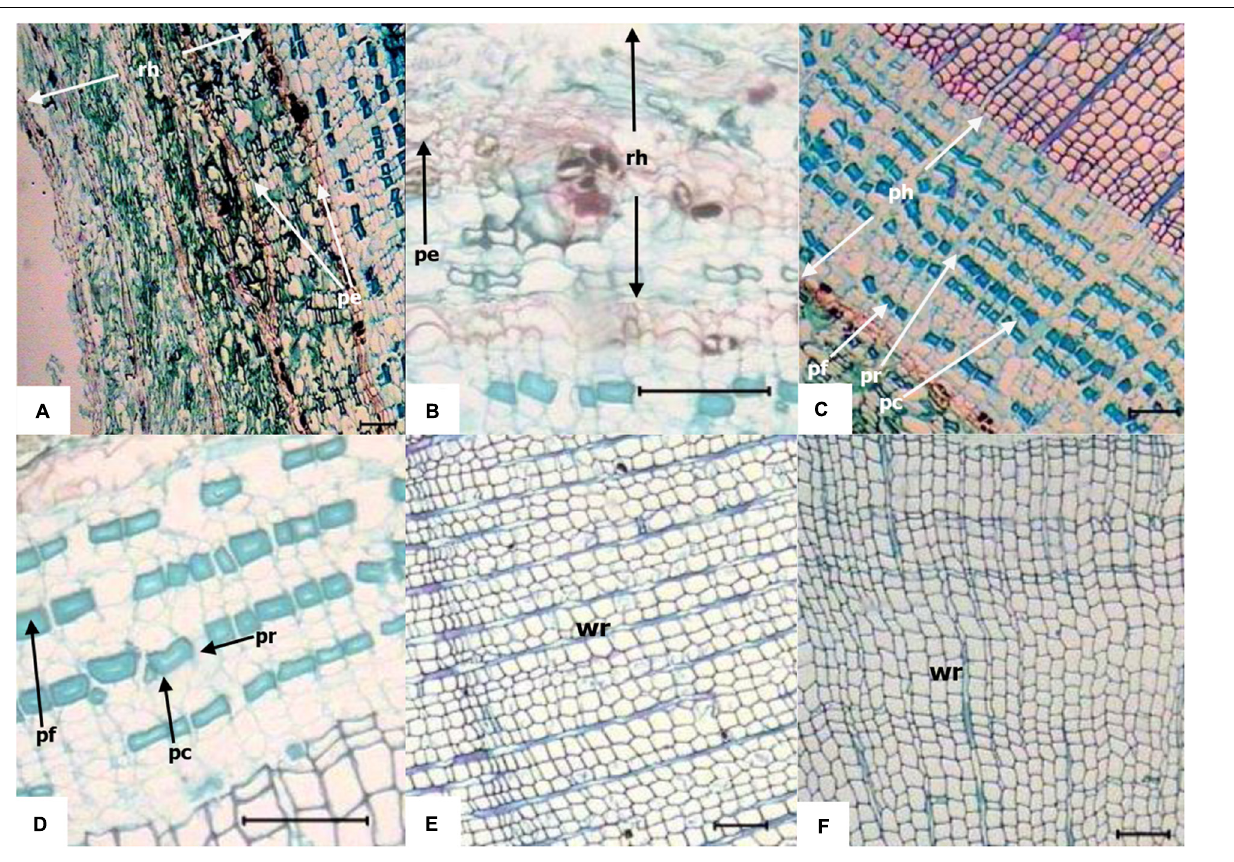
knee roots alleviated the anoxic stress of T. ascendens , possibly resulting in significantly lower ACS activity in the knee